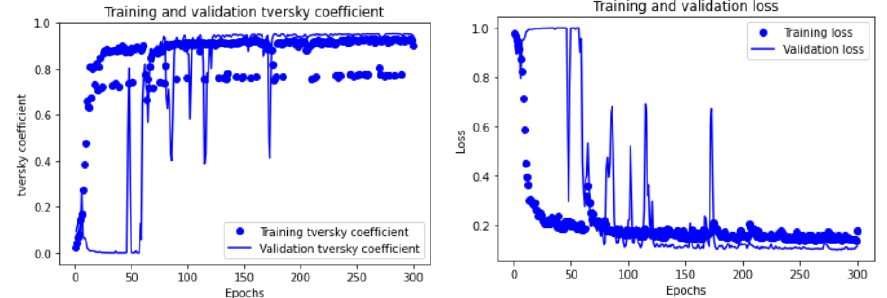
Figure 11. TL training and validation curves after 300